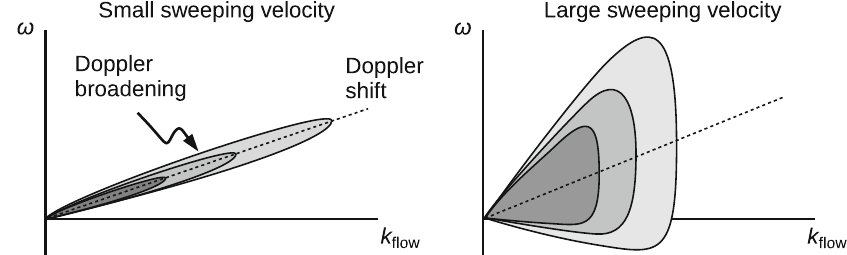
Fig.3 Differentrealizationsofenergyspectrafortherandomsweepingmodelofhydrodynamicturbulence in the two-dimensional spectral domain spanning the Eulerian frequencies ω (standing in a flow) and the streamwise wavenumbers k flow . Doppler shift and broadening over frequencies are associated with the mean flow speed and the large-scale flow speed variation,